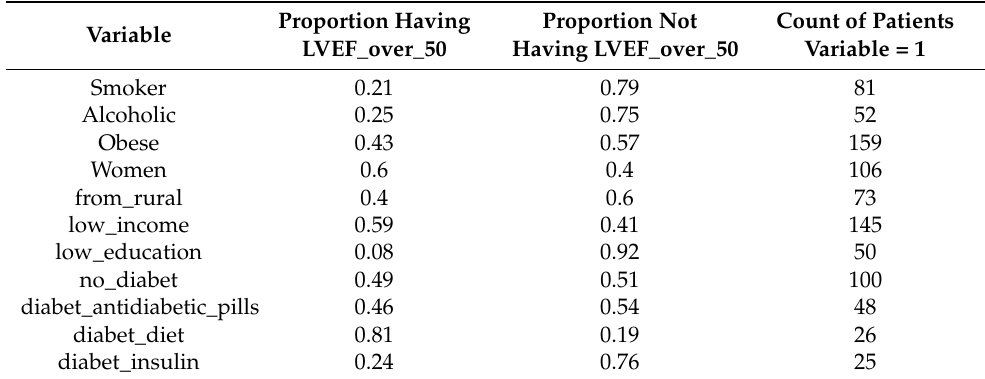
Figure 1. Correlation matrix between variables. Table 2. The proportionof patient’s diagnostics by each